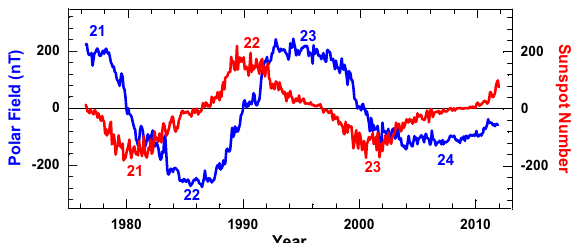
Fig. 1. The Hale magnetic cycle in the north-south average of the polar field, as observed at the Wilcox Solar Observatory (http:// wso.stanford.edu) in the interval 1975.5–2010 (blue) and the sunspot number curve (red) to which the sign is assigned according to the toroidal field polarity of successive Schwabe cycles. The polar maxima are numbered by the standard numbers of the next following sunspot maxima.